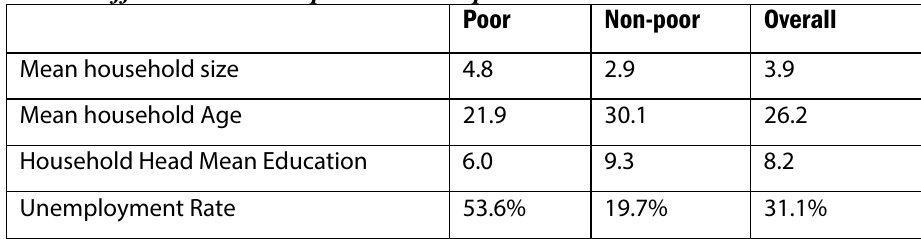
Table 1: difference between poor and non-poor households